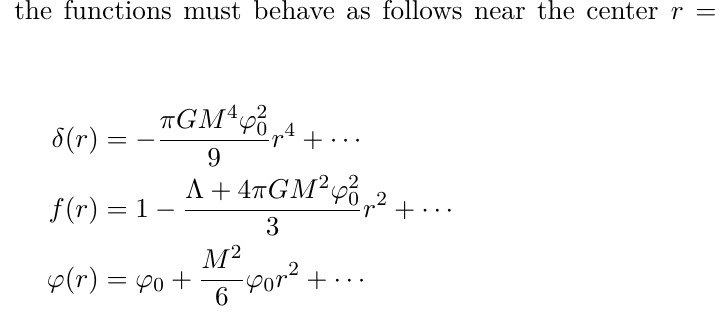
√ G, Λ = − 0 . 04 /G, M = 0 . 1 /